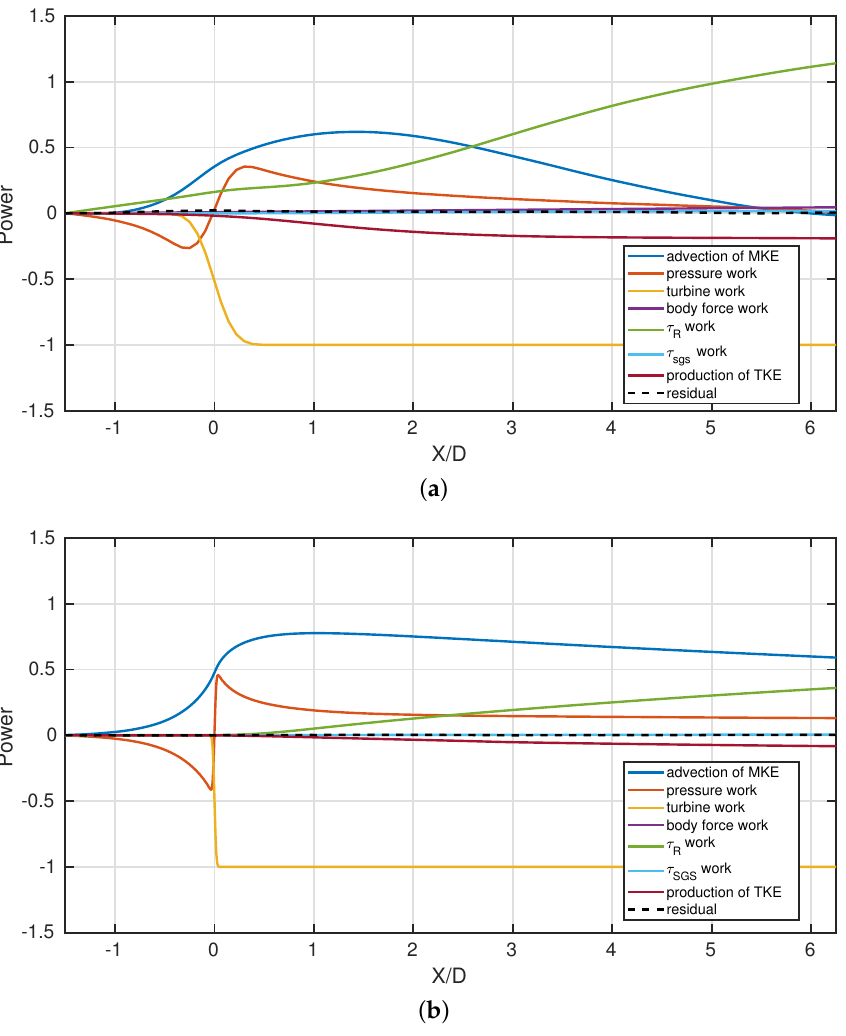
= 1.33 cases. Each term is normalized by Figure 13. Cumulative mean kinetic energy budgets for C (cid:48) T the magnitude of the total turbine power. ( a ) Wind farm and ( b ) isolated actuator disk. X / D = 0 is the location of the actuator disk. The budget for ( a ) is constructed by starting with the curves in Figure 5 and integrating from upstream to downstream. The budget for ( b ) is generated in the same manner using data from Ghate et al.